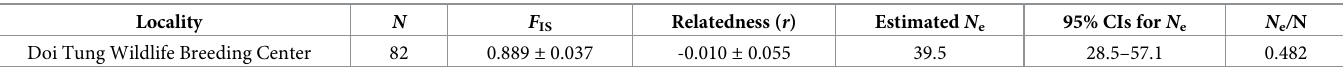
Table 2. Inbreeding coefficients, relatedness, effective population size, and ratio of effective population size and census population ( N e /N ) of Hume’s pheasant ( Syr- maticus humiae , Hume 1881) captive population at the Doi Tung Wildlife Breeding Center. Locality N F IS Relatedness ( r ) Doi Tung Wildlife Breeding